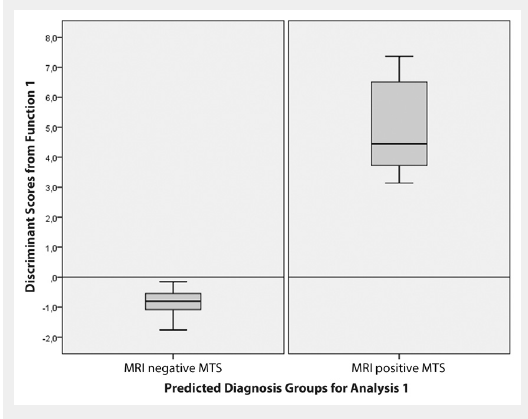
Box plots of the average D scores of DA illustrate the distribution of the discriminant function scores for each group. There is a visual demonstration of an excellent discrimination by showing the absence of overlap between